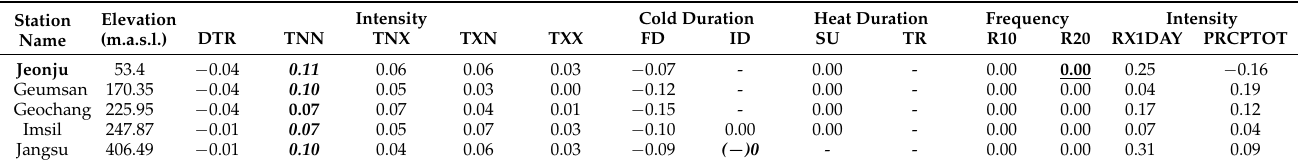
Table A17. Trend magnitudes for the month of November in the UGRB for 33 years (1988–2020).